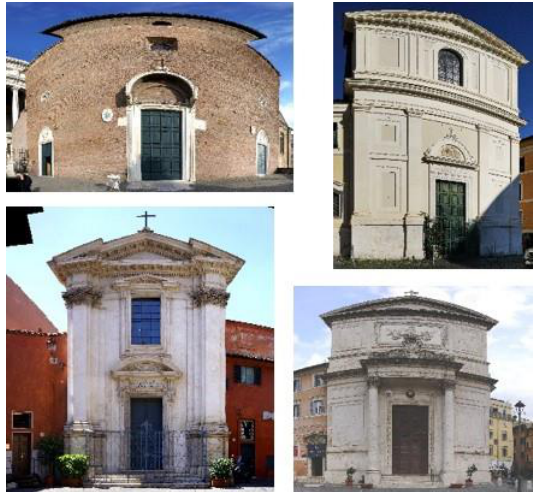
Figure 14 – Churches documented with three panoramas;